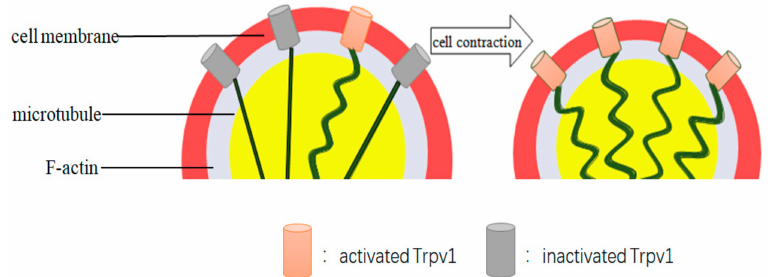
Figure 3. The “push” force-activation model of TRPV 1 is activated by additional microtubule (MT) forces in MNCs. In the resting condition, only a few TRPV 1 channels are activated due to the lack of a corresponding “push” force (left). As hypertonic cells contract, the membrane moves inward, and more TRPV 1 channels are activated by MTS (the right